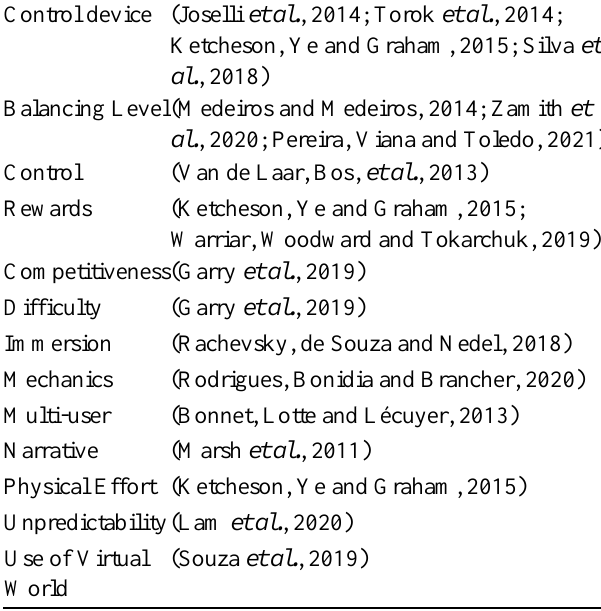
Figure 1. Selected papers over the years.